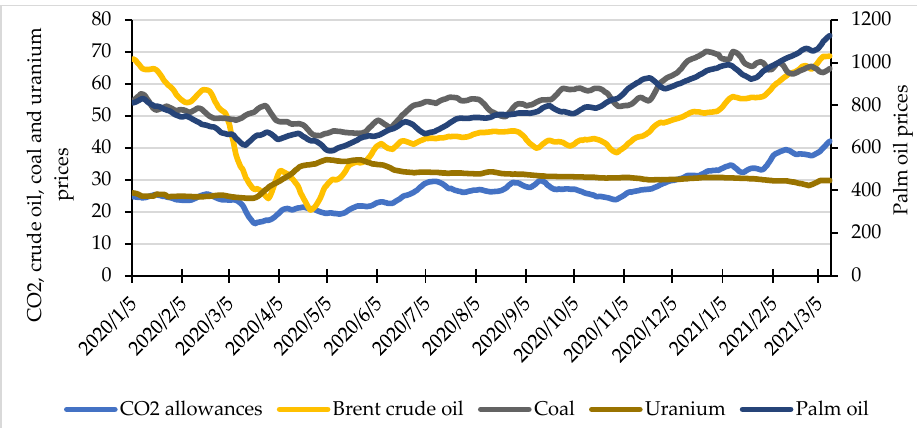
Figure 1. CO 2 allowances, crude oil, coal, uranium, and palm oil prices. Source: own elaboration on the basis of data from www.stooq.com (accessed on 19 April 2021).